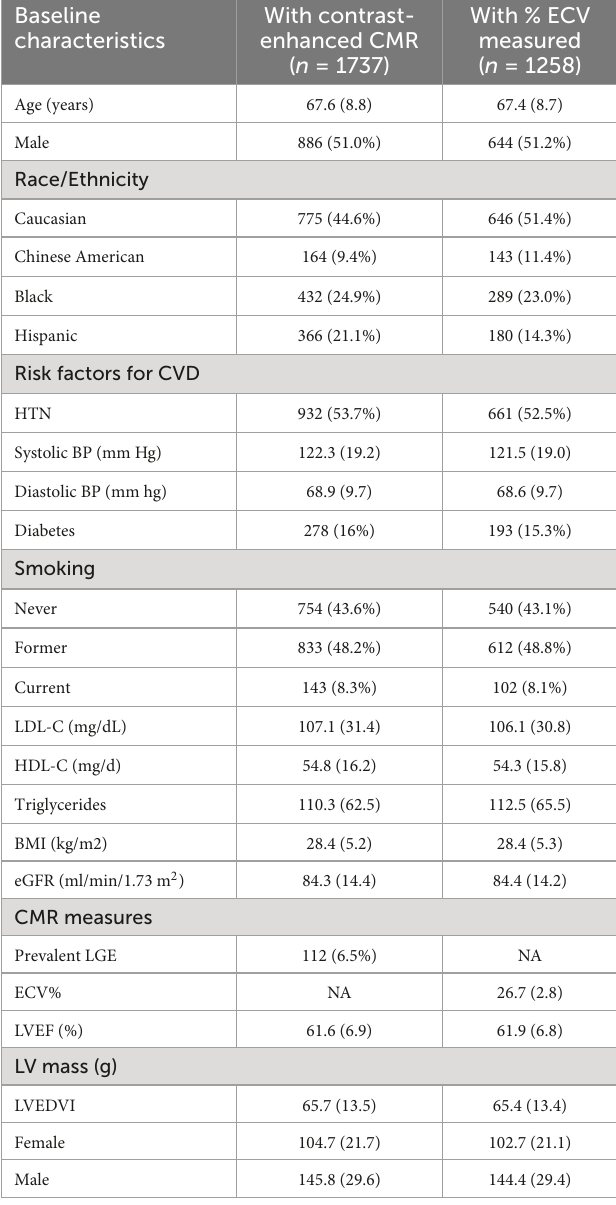
TABLE 1 MESA exam 5 participant characteristics for those with gadolinium enhanced CMR and with ECV